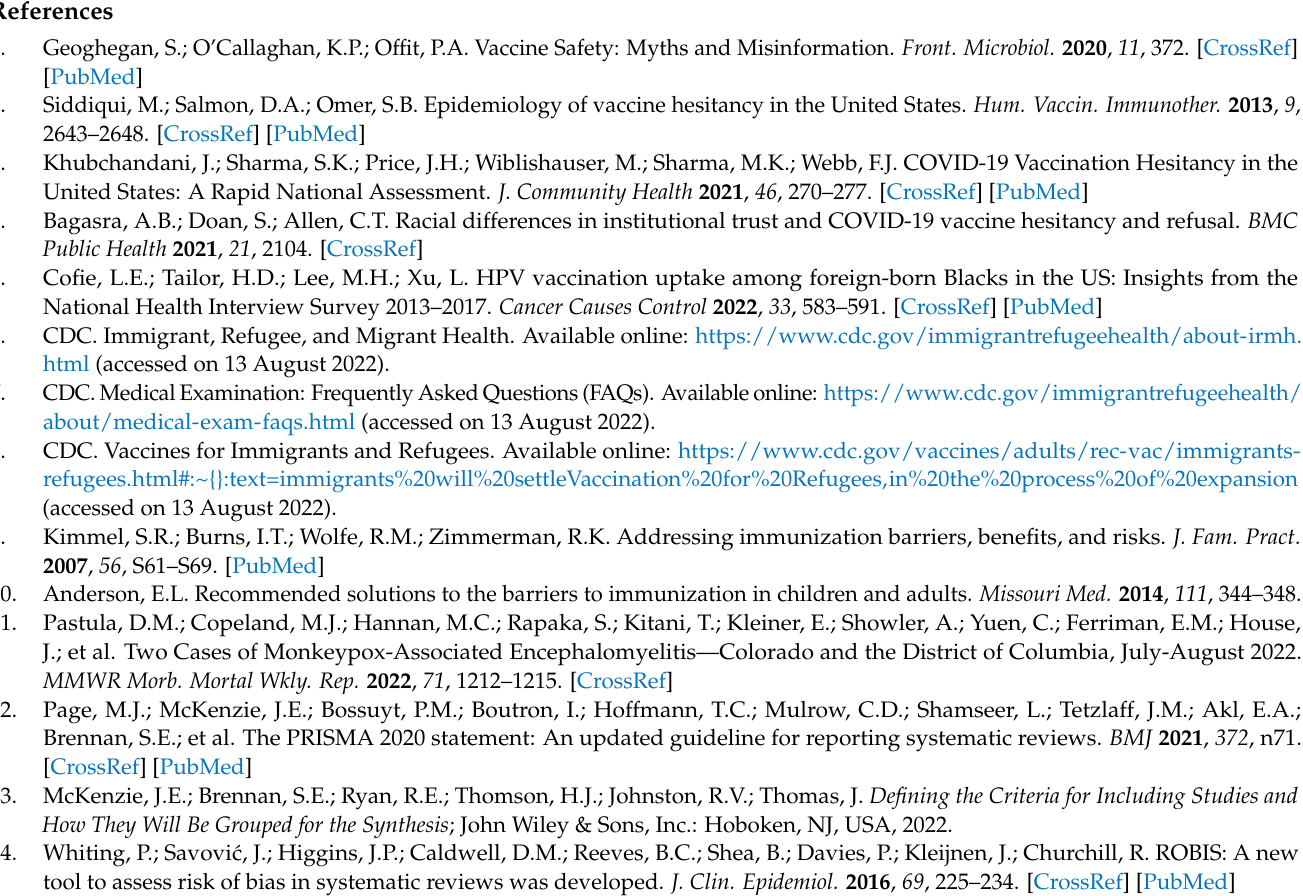
Figure A1. Graphical presentation of ROBIS evaluation results from this review.